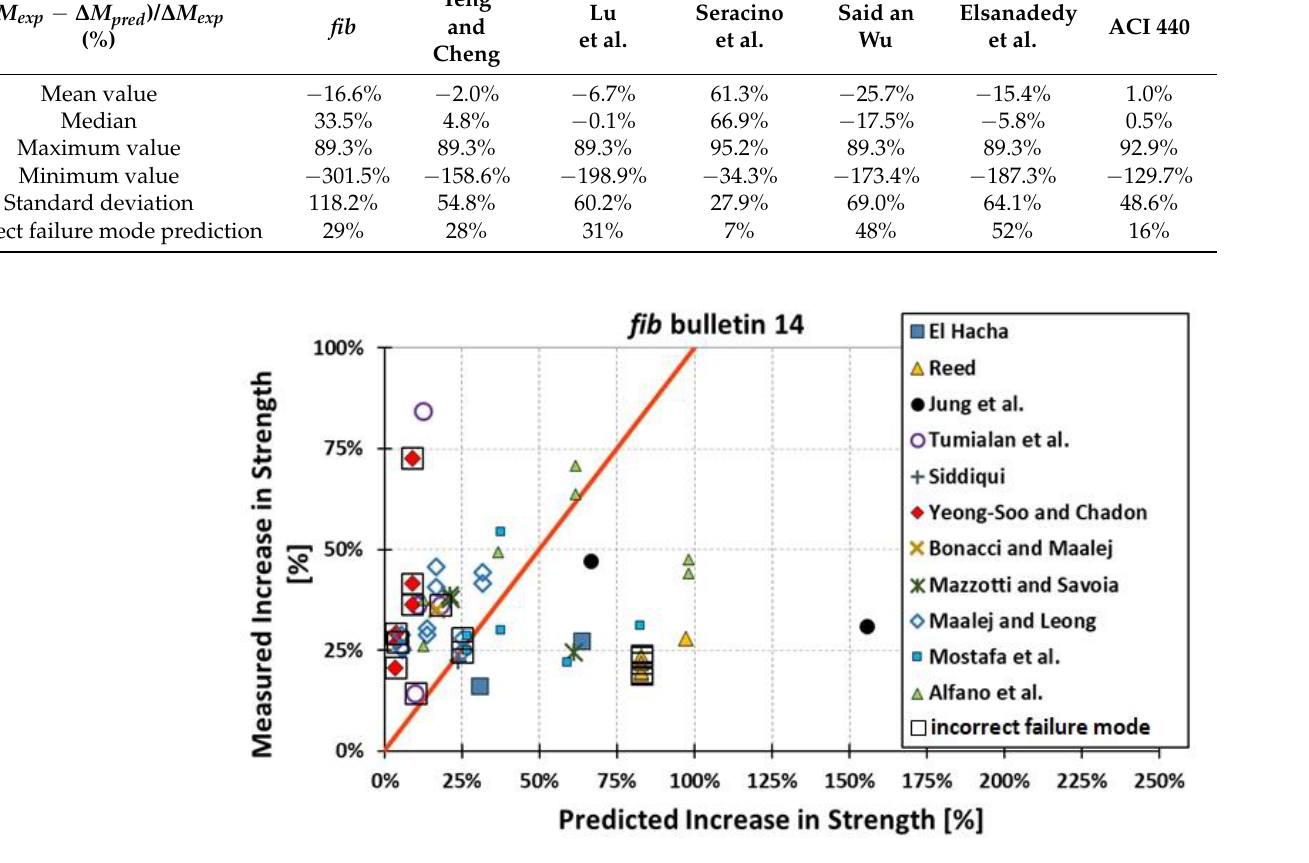
Figure 13. Measured increase in flexural strength versus Teng et al. model prediction. Figure 14. Measured increase in flexural strength versus Lu model prediction.